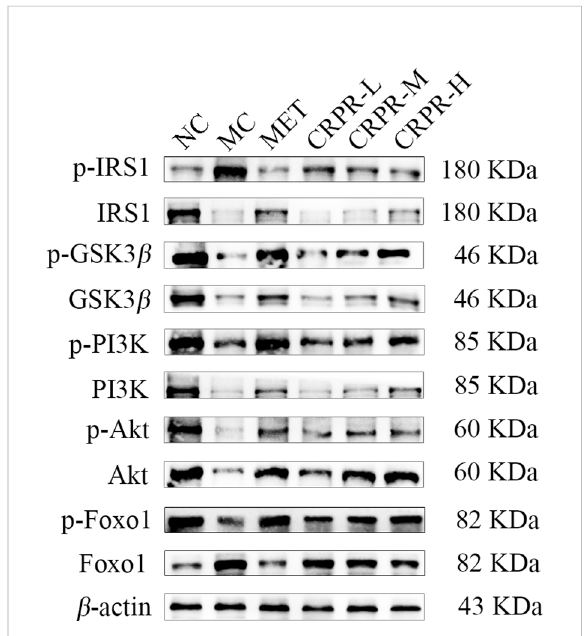
FIGURE 7 Representative Western blot analysis of p-IRS1, IRS1, p-GSK3 b , GSK3 b , p-PI3K, PI3K, p-Akt, Akt, p-FOXO1, and FOXO1.